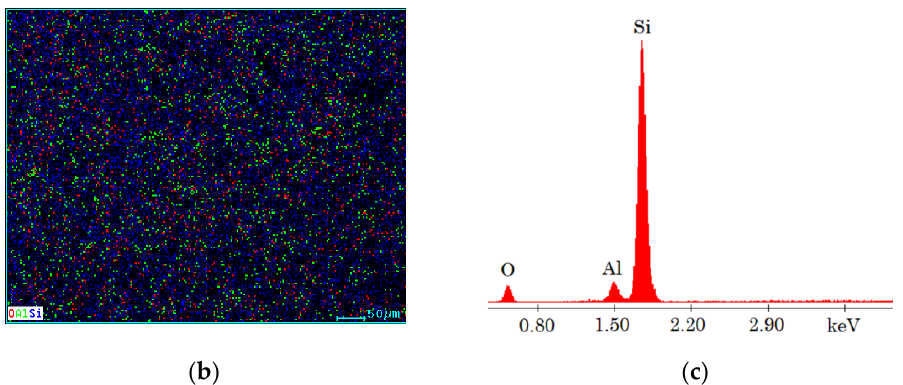
Figure 4. ( a ) SEM image of composite sample D; ( b ) element mapping; and ( c ) EDX spectrum for sample D.